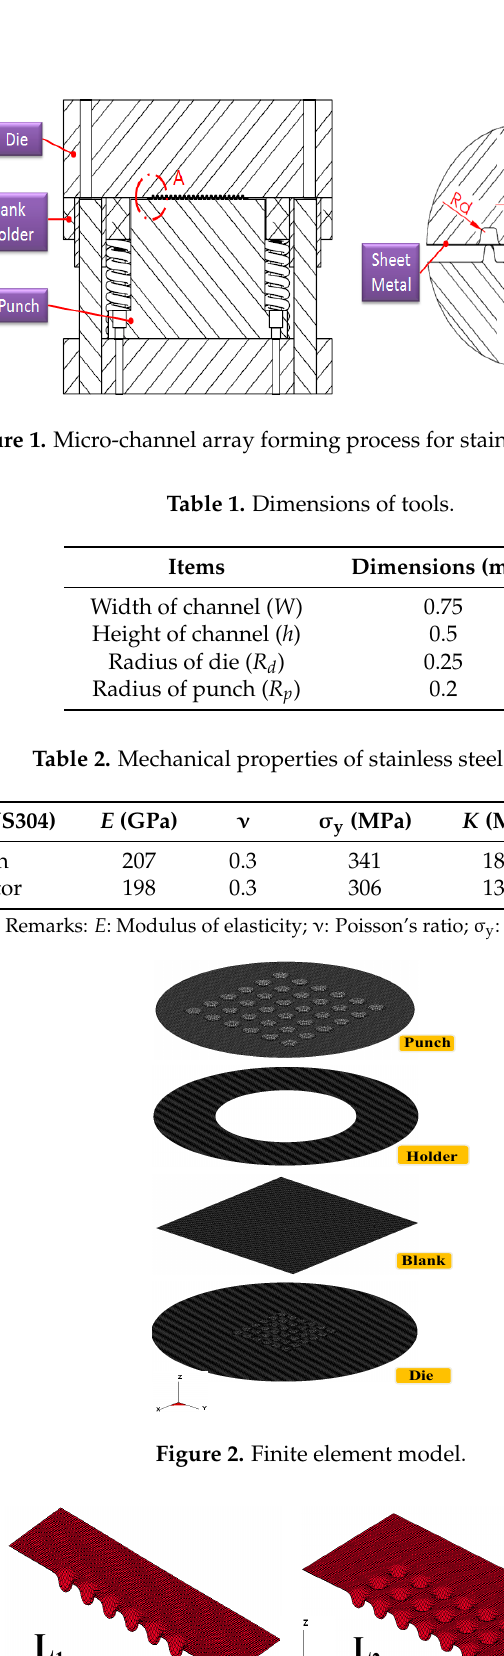
Figure 3. Measurement schematic diagram.